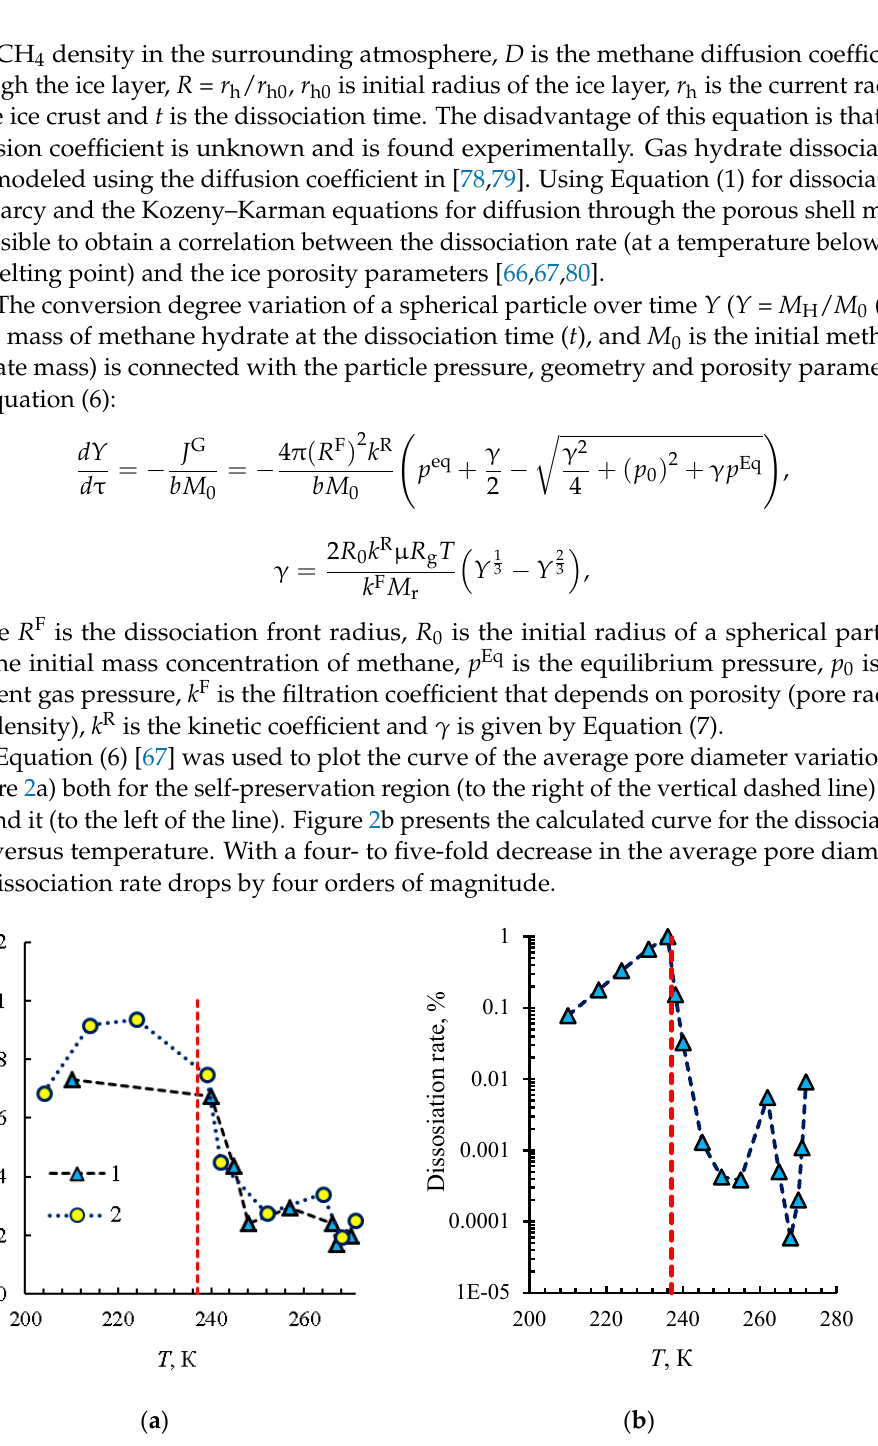
Figure 2. ( a ) The dependence of the pore diameter on the dissociation temperature (at negative temperatures) [67]; ( b ) The dependence of the integral dissociation rate of methane hydrate on the dissociation temperature.